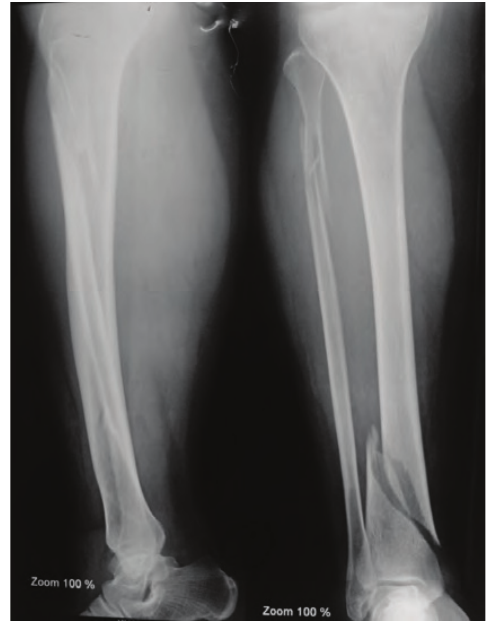
Figure 5: Six weeks after surgery, alignment maintained